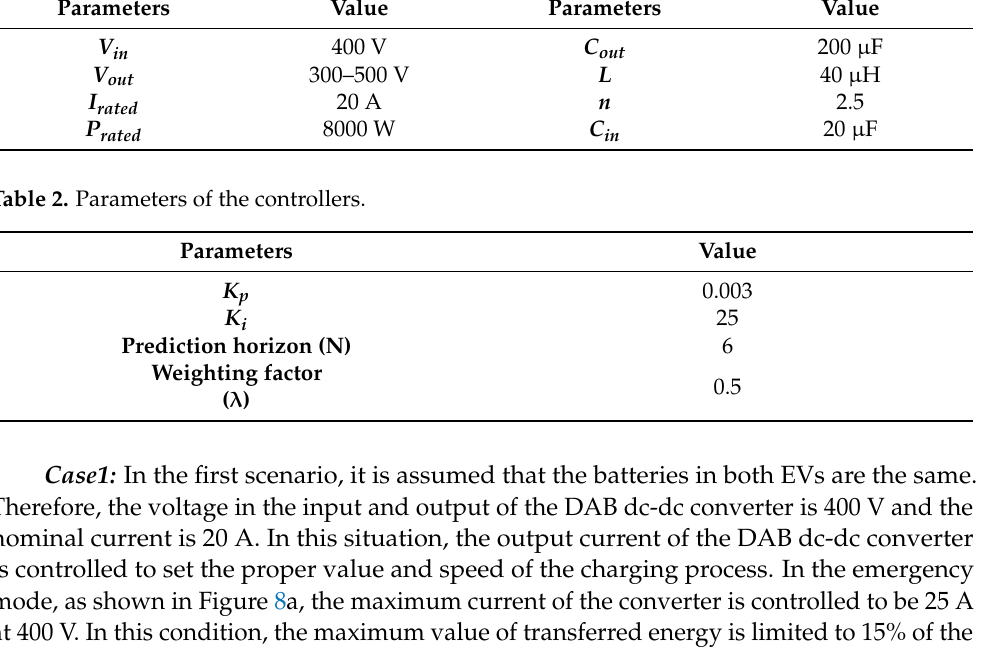
Figure 9. Comparison of the voltage transient responses of the proposed MF-NIBC controller, MPC, and the conventional PI controller during a step change in the output power in the first sce-